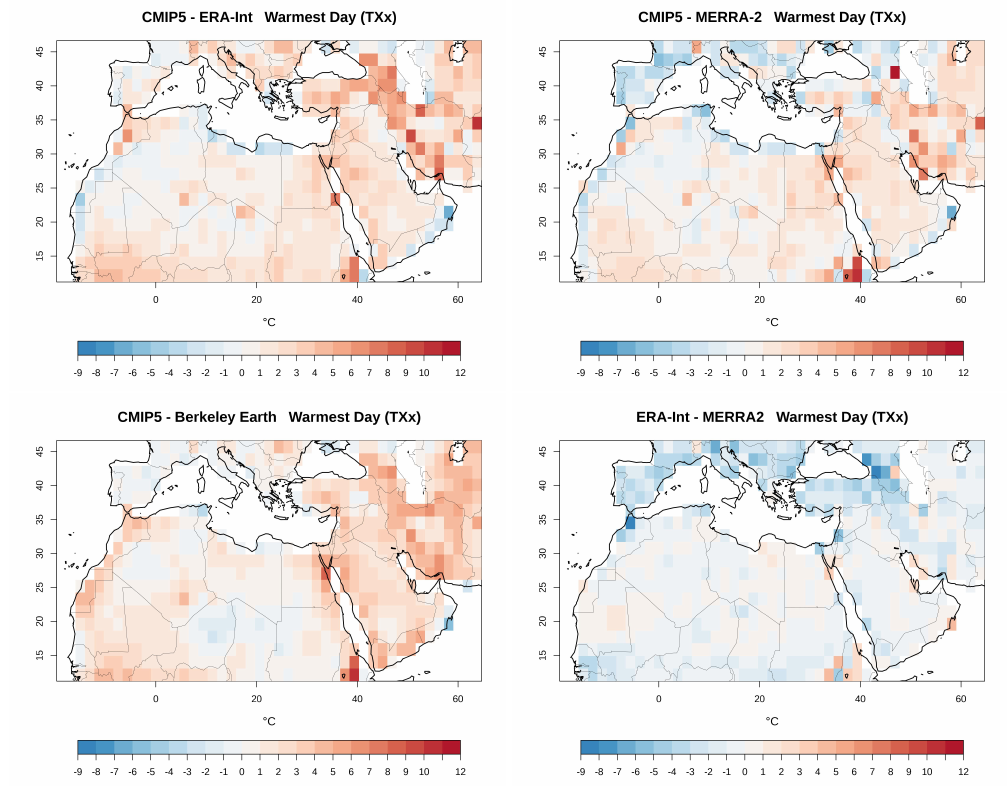
Figure A1. Maps of differences for the 1980-2018 climatology of the Warmest Day (TXx) for: CMIP5—ERA-Interim ( top left ), CMIP5—MERRA-2 ( top right ), CMIP5—Berkeley Earth ( bottom left ), ERA-Interim—MERRA-2 ( (bottom right